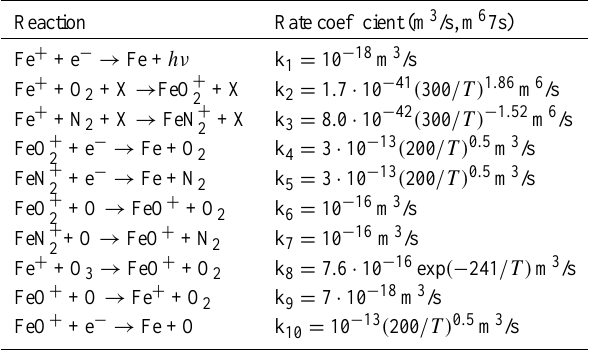
Table 1. Rate coefficients of reactions leading to the neutralization of the Fe + ions